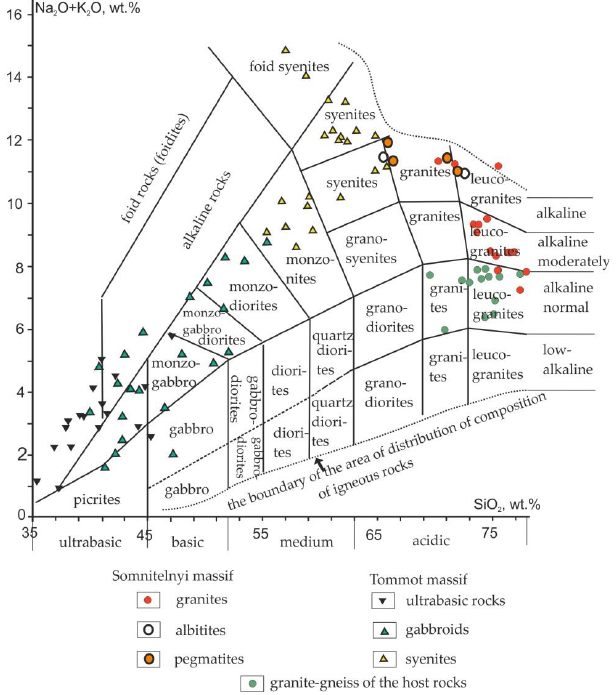
Figure 8. TAS diagram for rocks of the Tommot ore field. Diagram fields after [50].